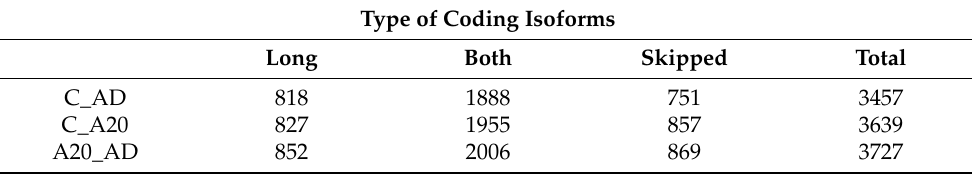
Table 4. Distribution of total consistent coding ES events in pairwise comparisons.